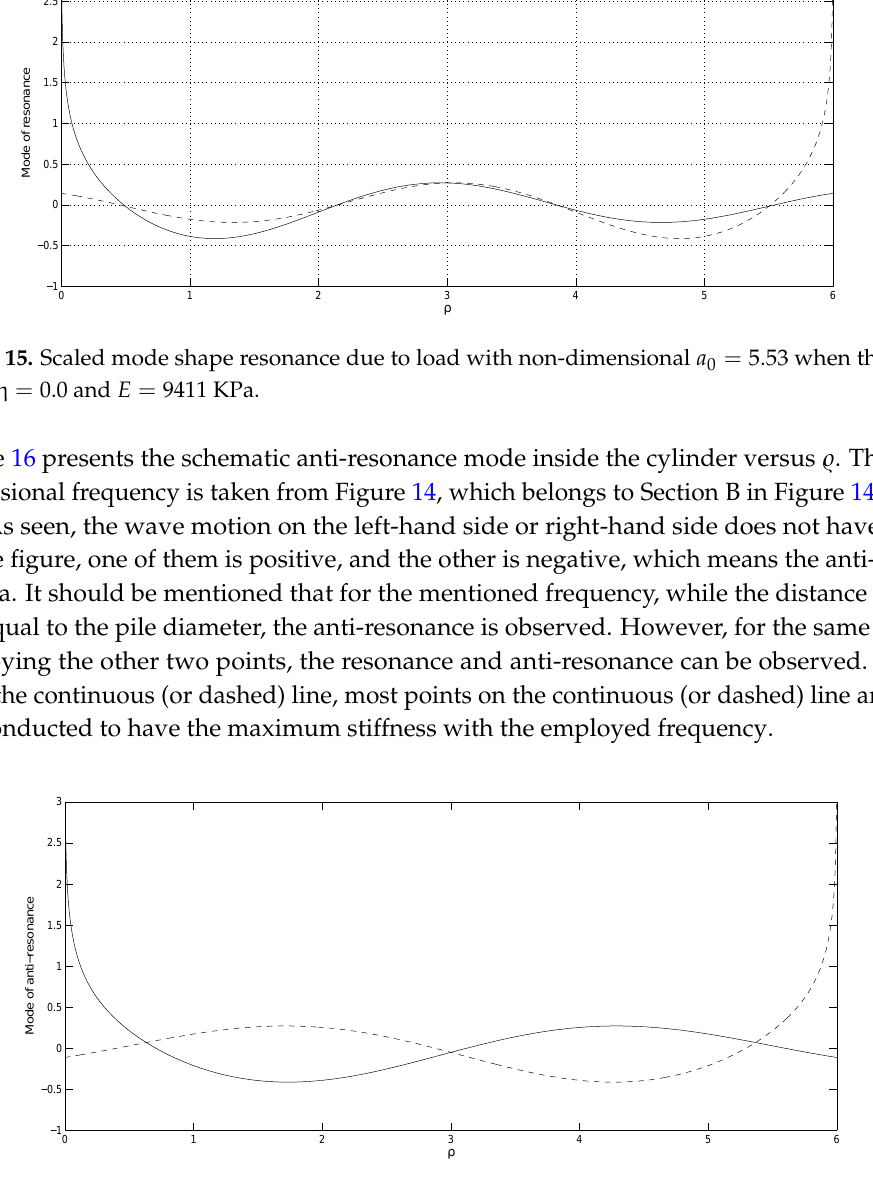
Figure 16. Scaled mode shape resonance due to the load with non-dimensional a 0 = 5.53 when the loss factor η = 0.0 and E = 9411